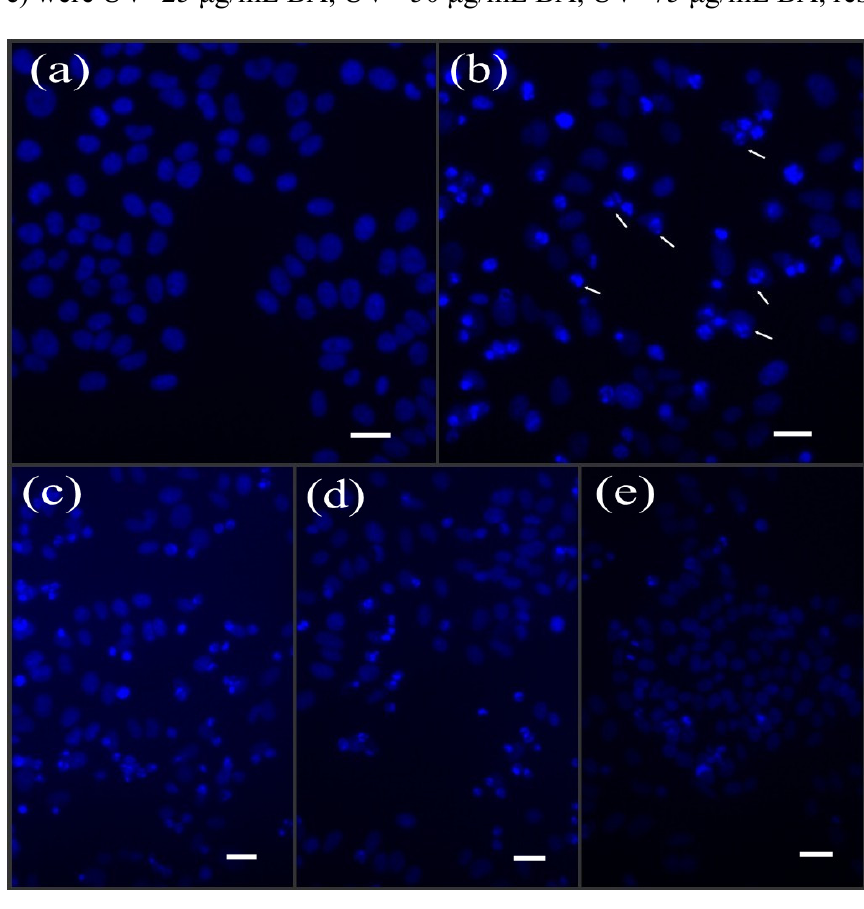
Figure 3. The effects of BA on chromatin condensation in HepG2 cells. Representative images of Hoechst 33258-stained cells observed under fluorescent microscopy after pre-treatment for 12 h with BA at different concentrations and then exposed to UV (scale bar: 50 μ M). ( a ) control (without UV radiation); ( b ) UV-radiation without BA; ( c , d , and e ) were UV+25 μ g/mL BA, UV+ 50 μ g/mL BA, UV+75 μ g/mL BA,